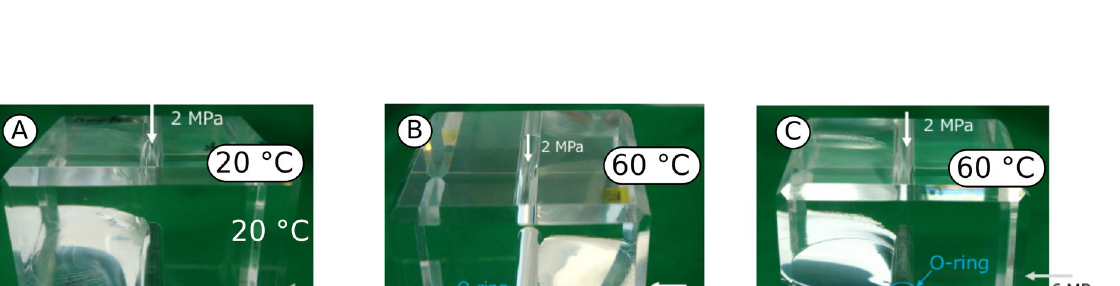
Figure 4. Deformation at the outer faces along the principal directions ( u h , u H and u v ) and acoustic emissions’ cumulative energy ( E AE ) during fluid injection in test procedure P1 (see “Methods”). Before failure ( t the onset of AE energy and displacement hints at fracturing process, while the displacements observed along different directions suggests mixed-mode fracture propagation and pre-failure plastic processes.